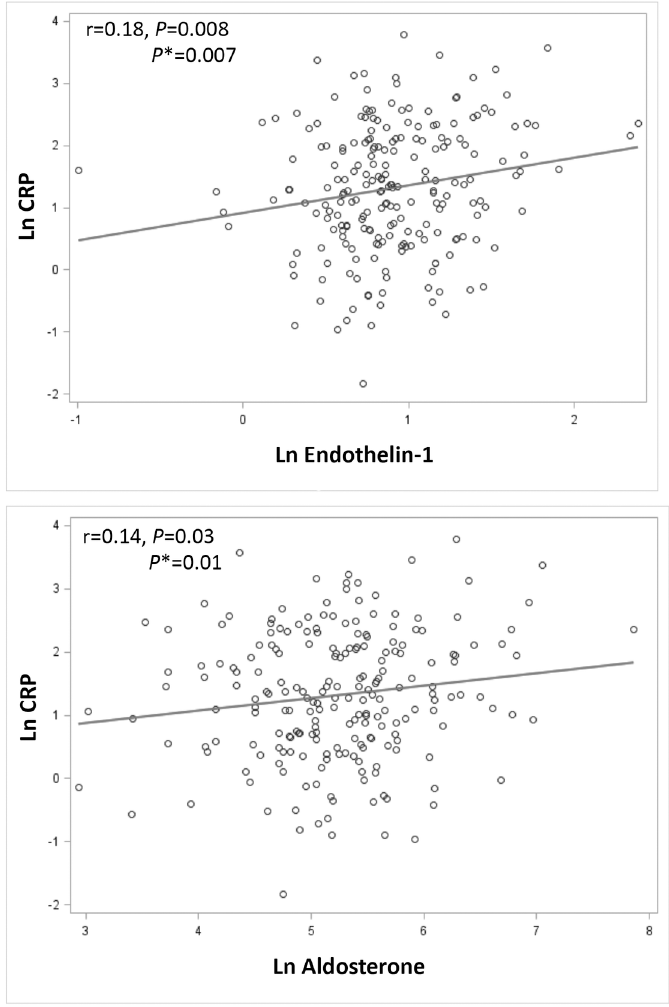
Fig 2. The relationship between C-reactive protein (CRP) and endothelin-1 and aldosterone in heart failure with preserved ejection fraction. CRP was significantly associated with endothelin-1 and aldosterone. Ln indicates log transformed. (cid:3) Adjusted for age, BMI and statin